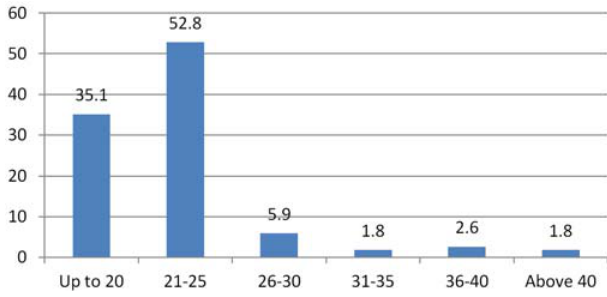
Fig. 2. Age group of respondents (bar chart)